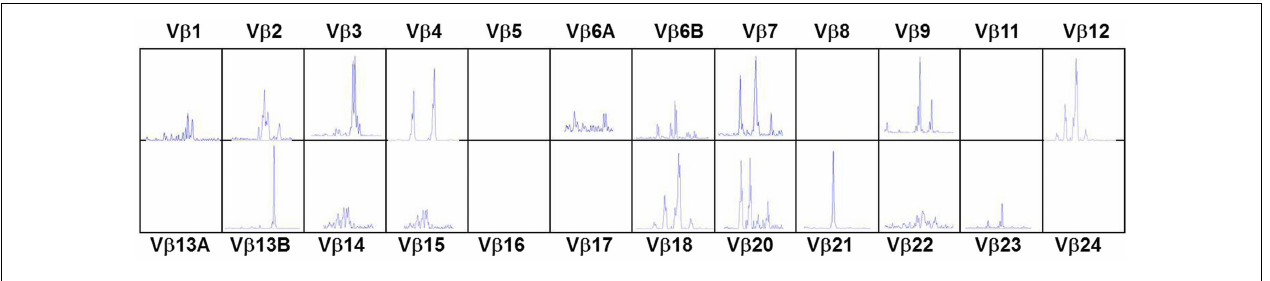
FIGURE 1 |T-cell receptor spectratyping of 24V β families obtained using polymerase chain reaction amplification across theVDJ region and then plotting according to the size of the PCR products. Patient